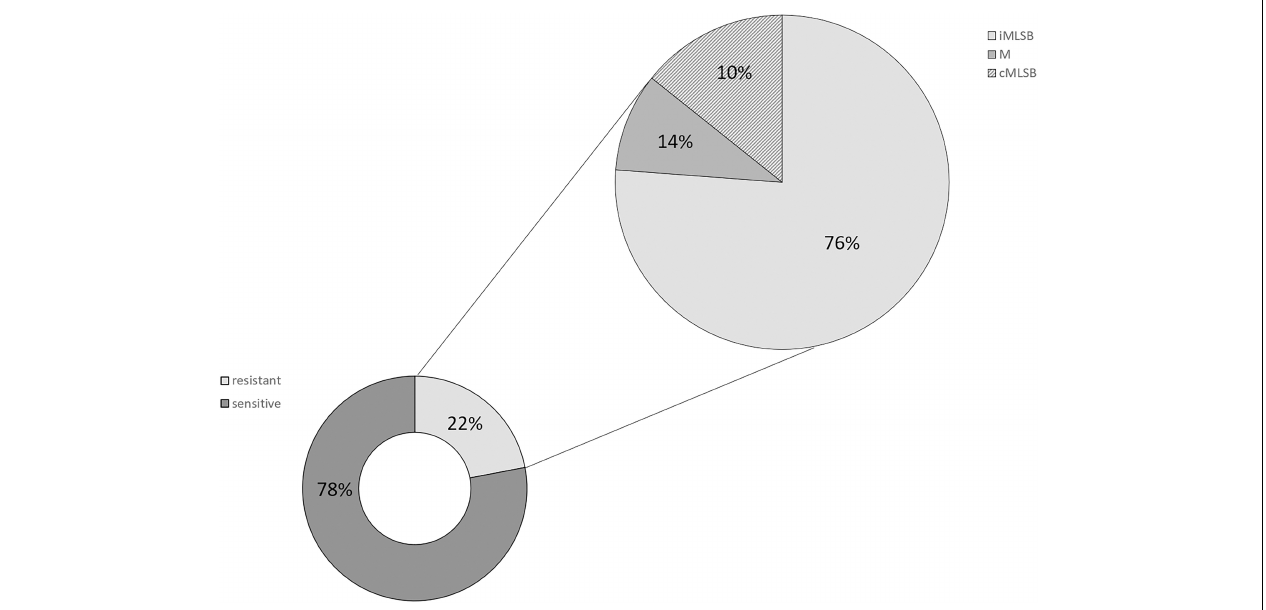
FIGURE 1 | Percentage distribution of particular resistance phenotypes (cMLS B , iMLS B ) (right side) of GBS isolated from UTI among the strains resistant to erythromycin and/or clindamycin (left side).